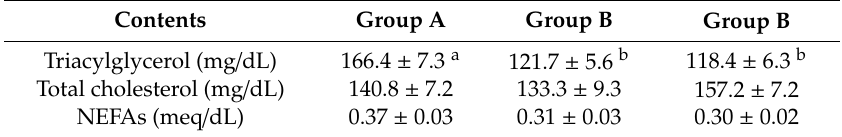
Table 2. Green tea ameliorated abnormalities in plasma lipids in KK-A y mice.